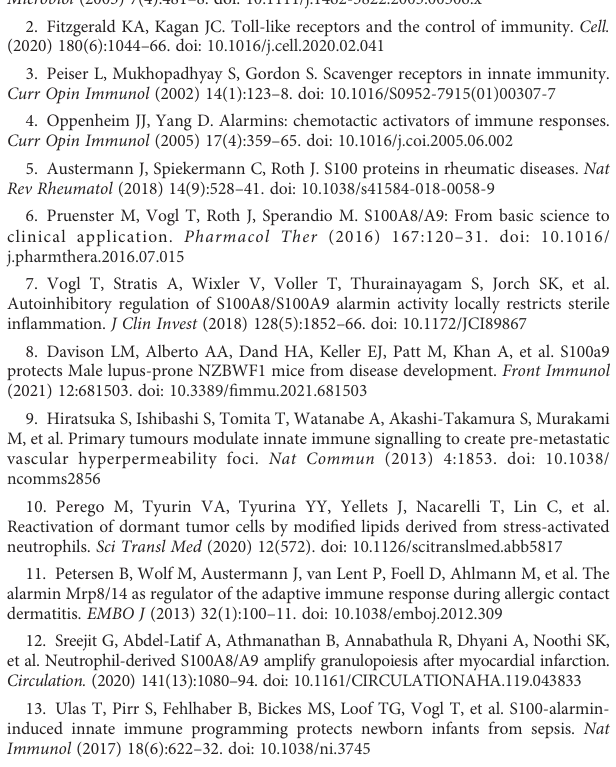
Relative cytokine secretion upon S100A8 and S100A9 stimulation. CD33, CD68,CD69, CD147andTLR4 knockoutER-Hoxb8 precursorcells, as wellas WT ER-Hoxb8 precursor cells were differentiated into macrophages and subsequently stimulated with LPS, S100A8 homodimer, S100A9 homodimer or incubated without stimulus (Ctrl). TNF- a (A) and IL-6 (B) protein levels in cell culture supernatants were quanti fi ed using LegendPlex ™ assay (n = 3). Concentrations below the limit of quanti fi cation were set as LLOQ/2. Fold changes of absolute cytokine values under S100 stimulation were calculated for each run with respect to mean cytokine values under LPS stimulation. Values are the means ± SEM. NS = not signi fi cant, by two-way ANOVA and Dunnett ’ s test in comparison to